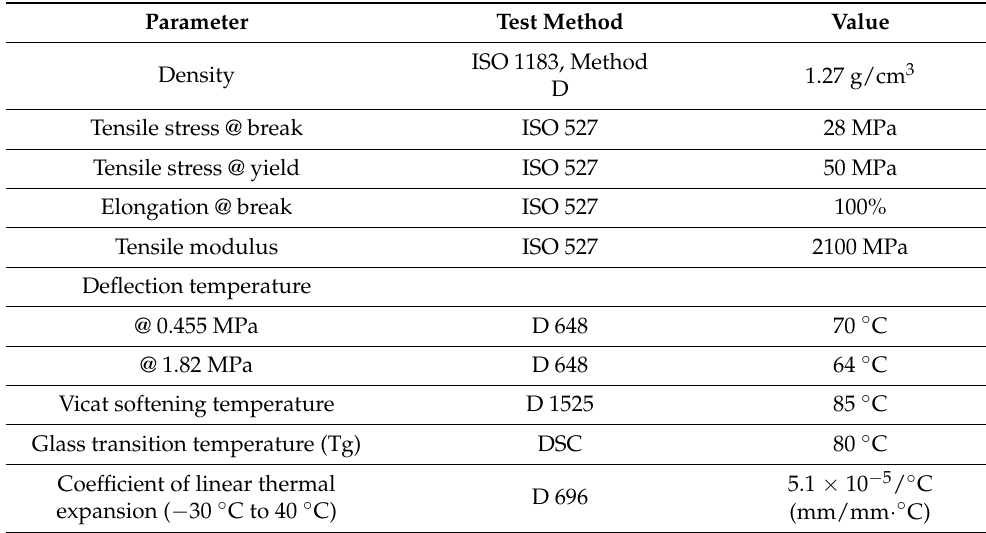
Table 1. PETG, the selected parameters of mechanical and thermal properties (injection molded), ISO method, [29].